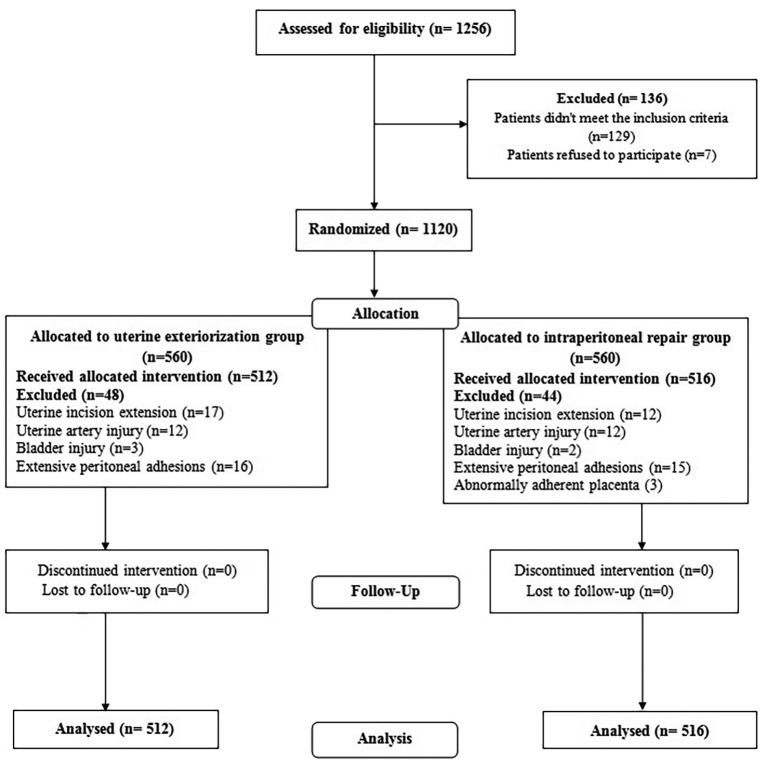
— The study flowchart.